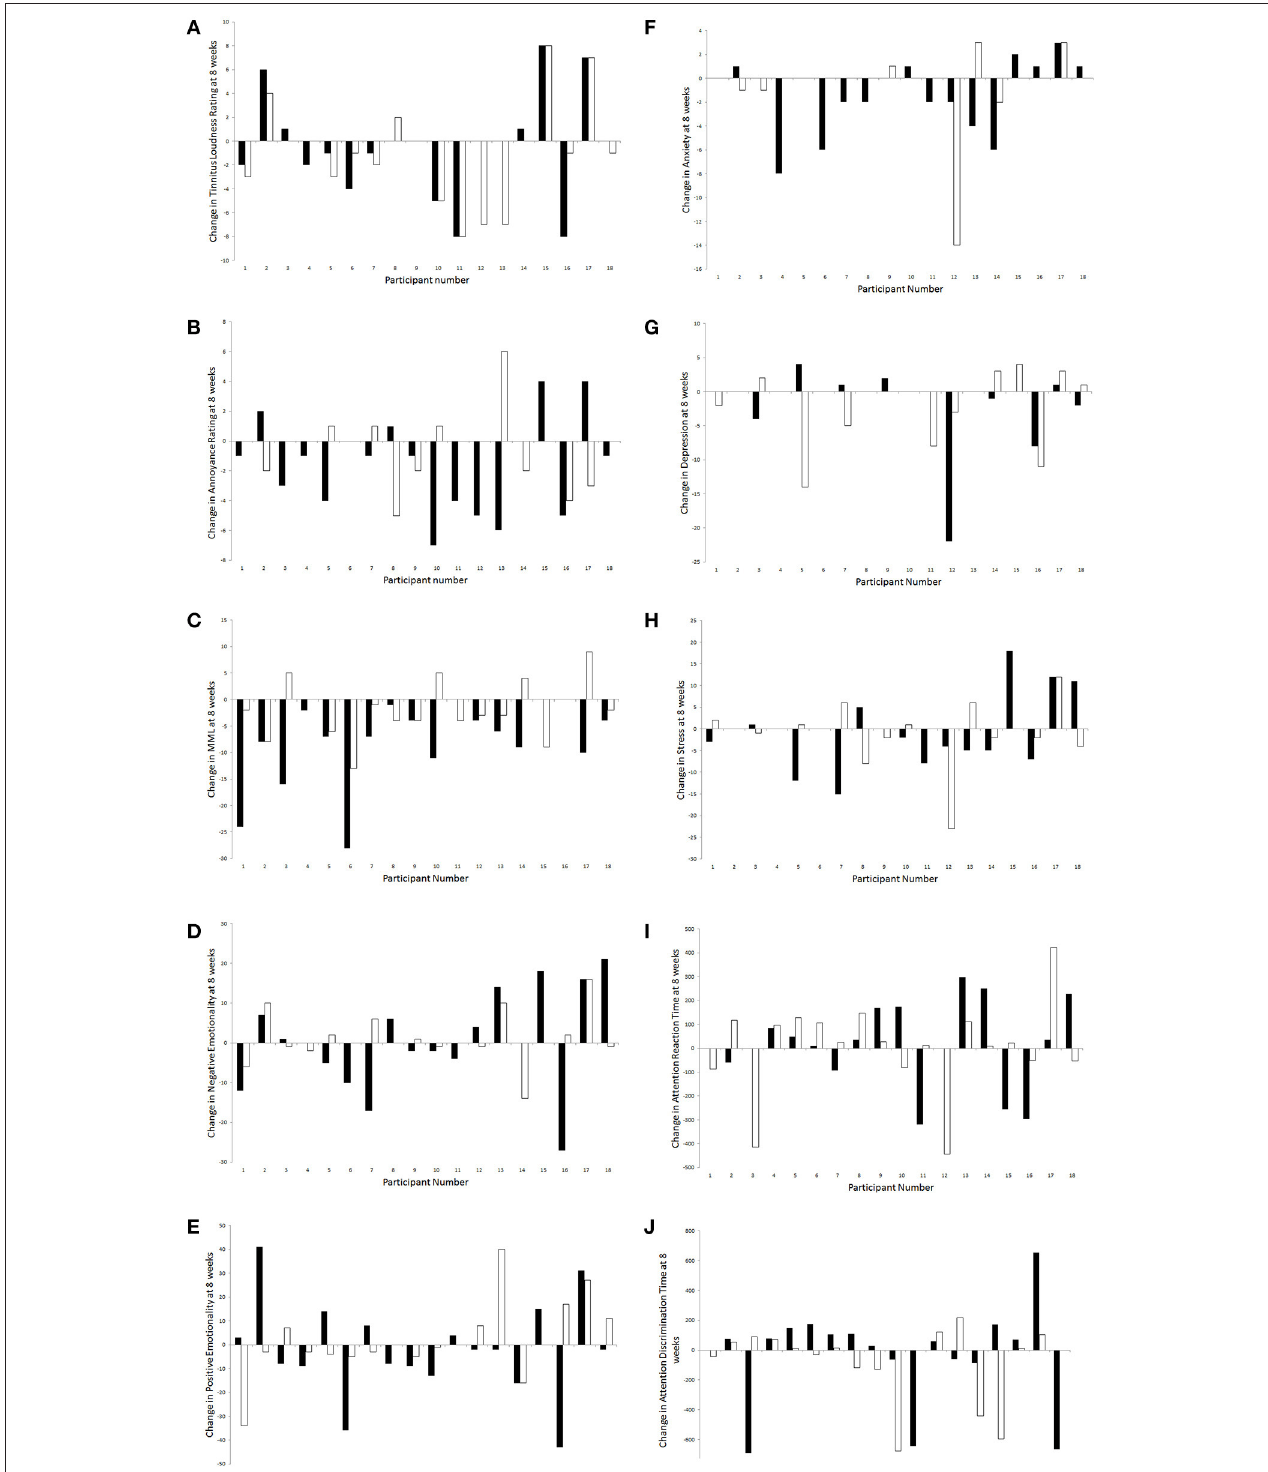
FIGURE 11 | Changes in outcome measures [(A) , tinnitus loudness ratings; (B) , tinnitus annoyance ratings; (C) , MML; (D) , negative emotionality; (E) , positive emotionality; (F) , anxiety; (G) , depression; (H) , stress; (I) , attention reaction time; (J) , attention discrimination time] for each participant following administration of BBN (black) and nature (white) sound